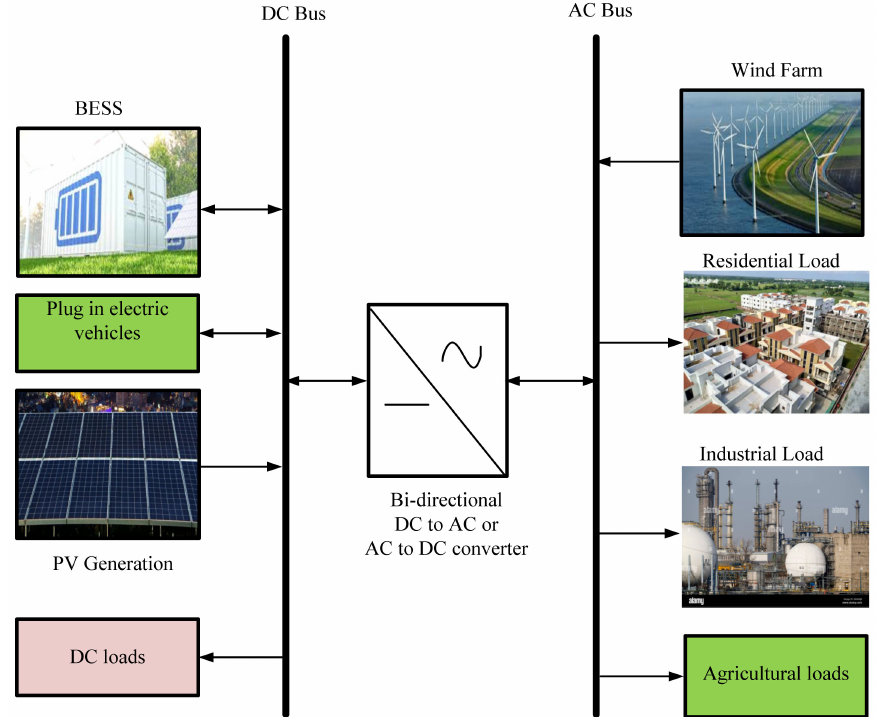
Figure 2. A general layout of hybrid MG.